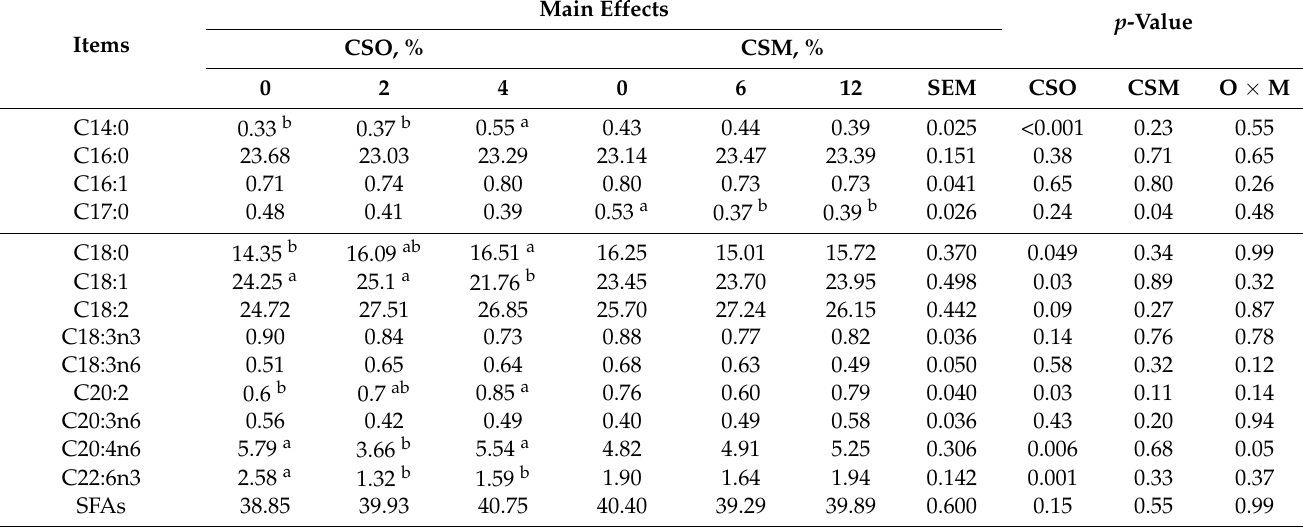
Table 4. Effects of cottonseed oil (CSO) and cottonseed meal (CSM) on fatty acid composition (g/100 g of total fatty acids) of livers in laying hens 1